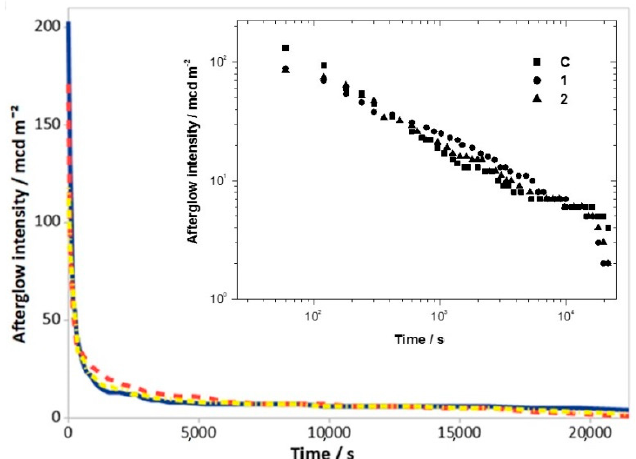
Figure 5. Decay curves of samples C (blue), 1 (red) and 2 (yellow). The upper inset showed the log-log plot.